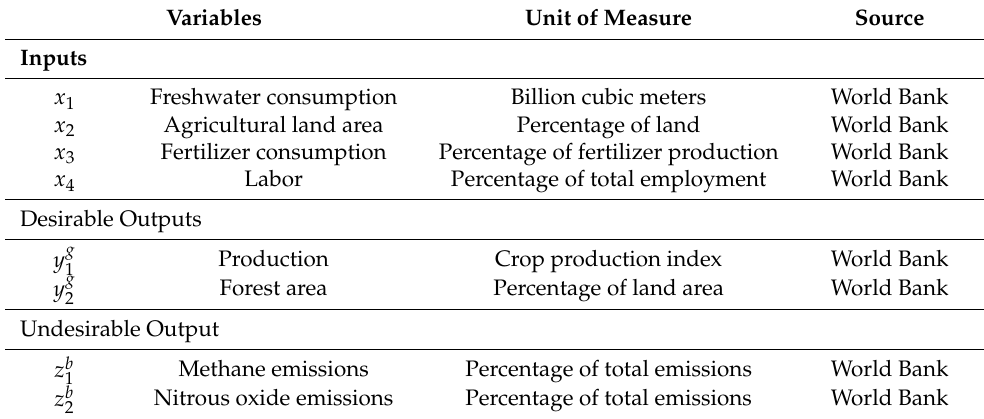
Table 3. Variables for the agro-ecological